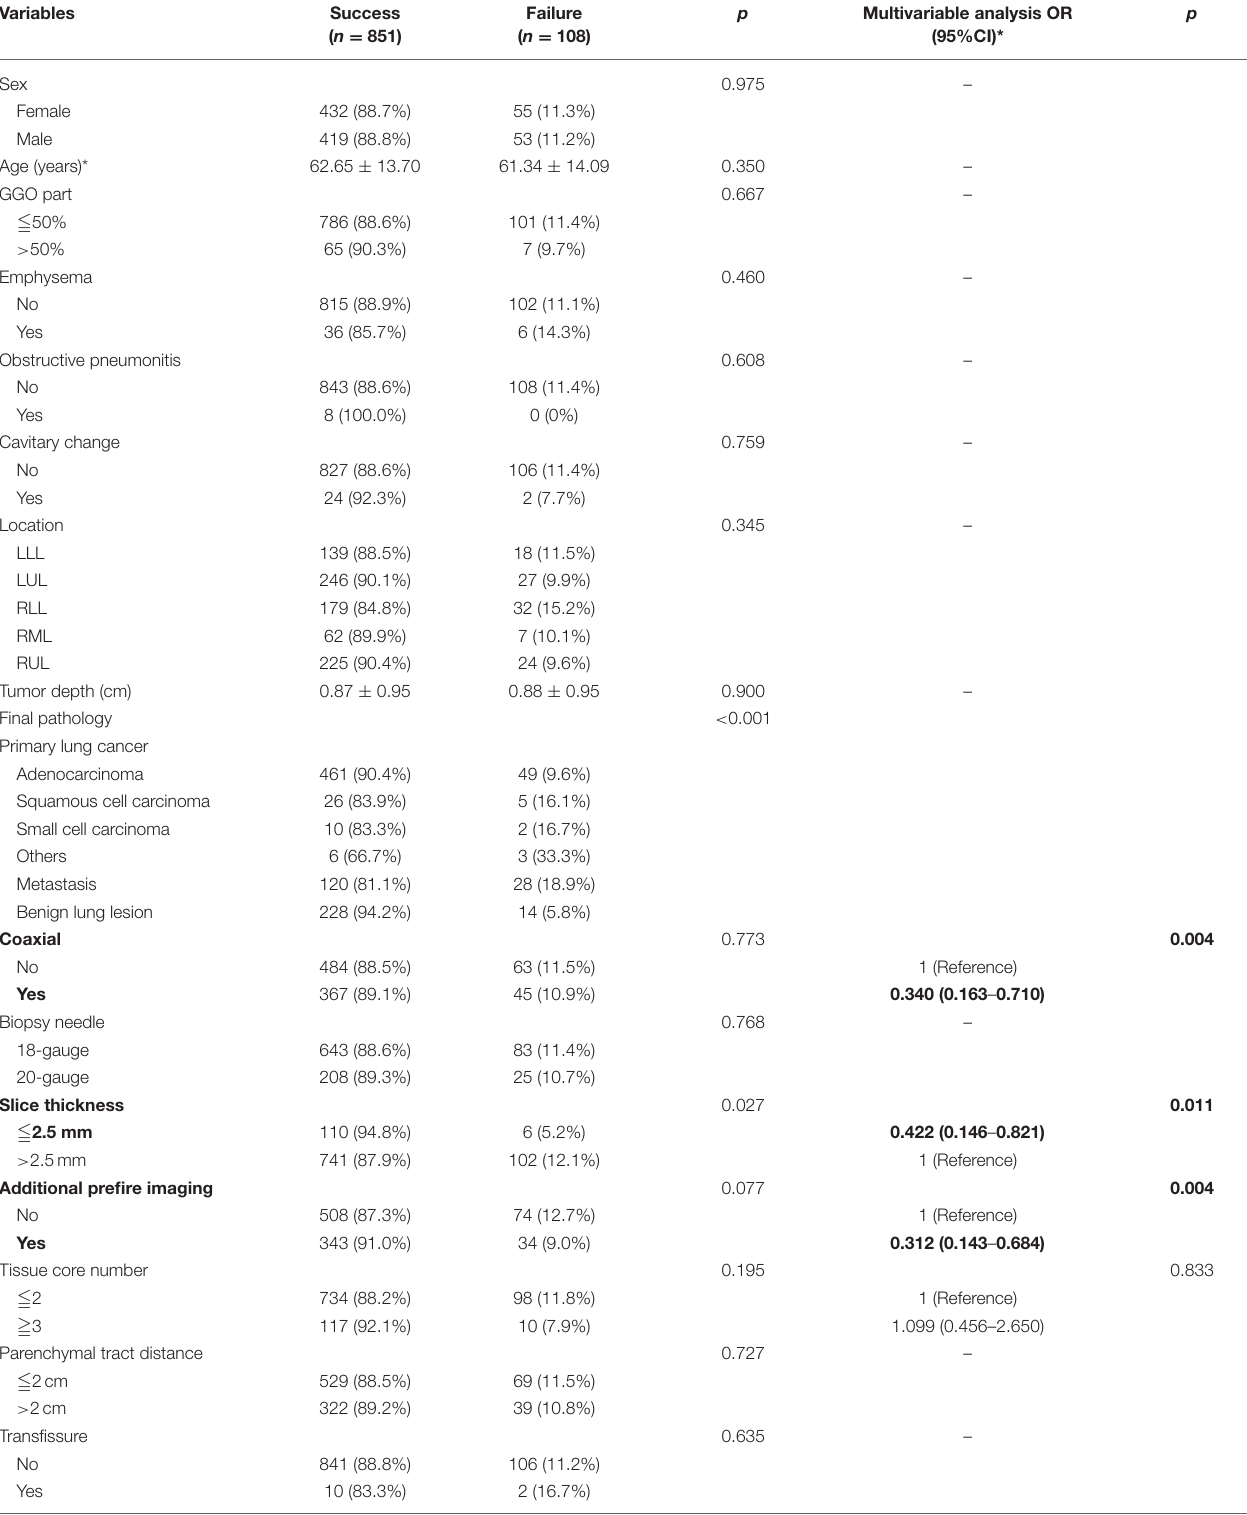
TABLE 2 | Predictors for diagnostic failure of CT-guided TTNB in lung tumor ≤ 3cm.